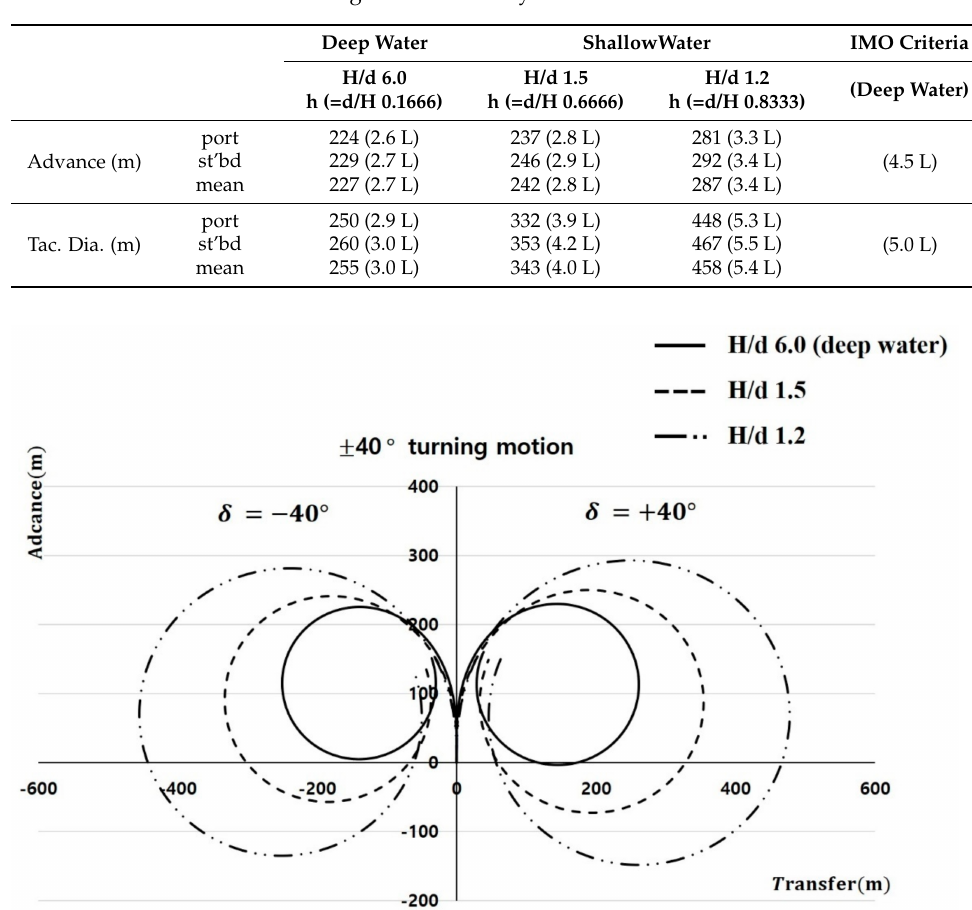
Table 10. Conditions for evaluating maneuverability in shallow water.